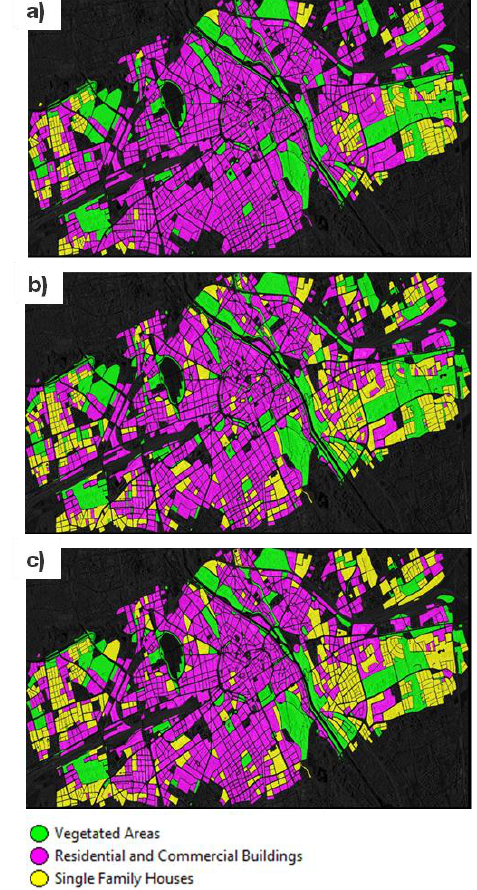
Figure 5. Ground-truth UST map (a), classification obtained with the ensemble of classifiers (b) and the reclassification obtained by the application of the CRFs model (c).